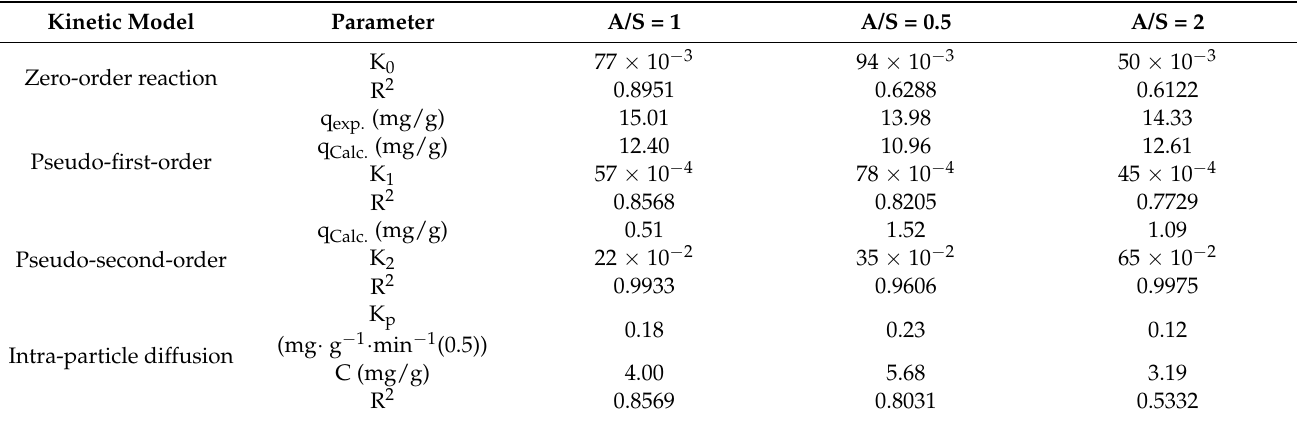
Table 4. Comparison between the estimated adsorption rate constants, rate constants, and cor- relation coefficients associated with the pseudo-first-order and pseudo-second-order rates and intra-particle